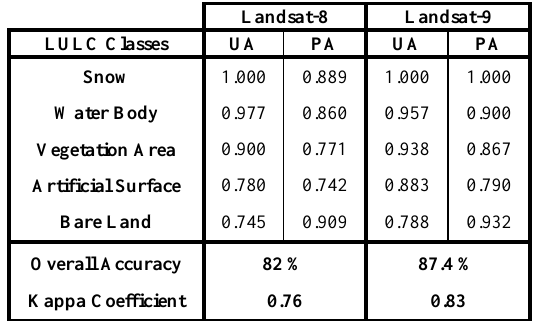
Table 1. Validation results for LULC images